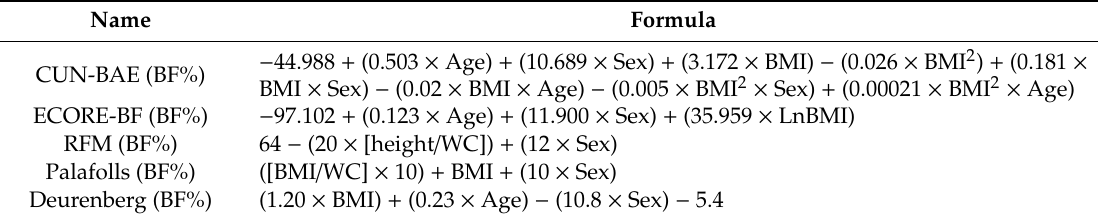
Table 1. Estimation